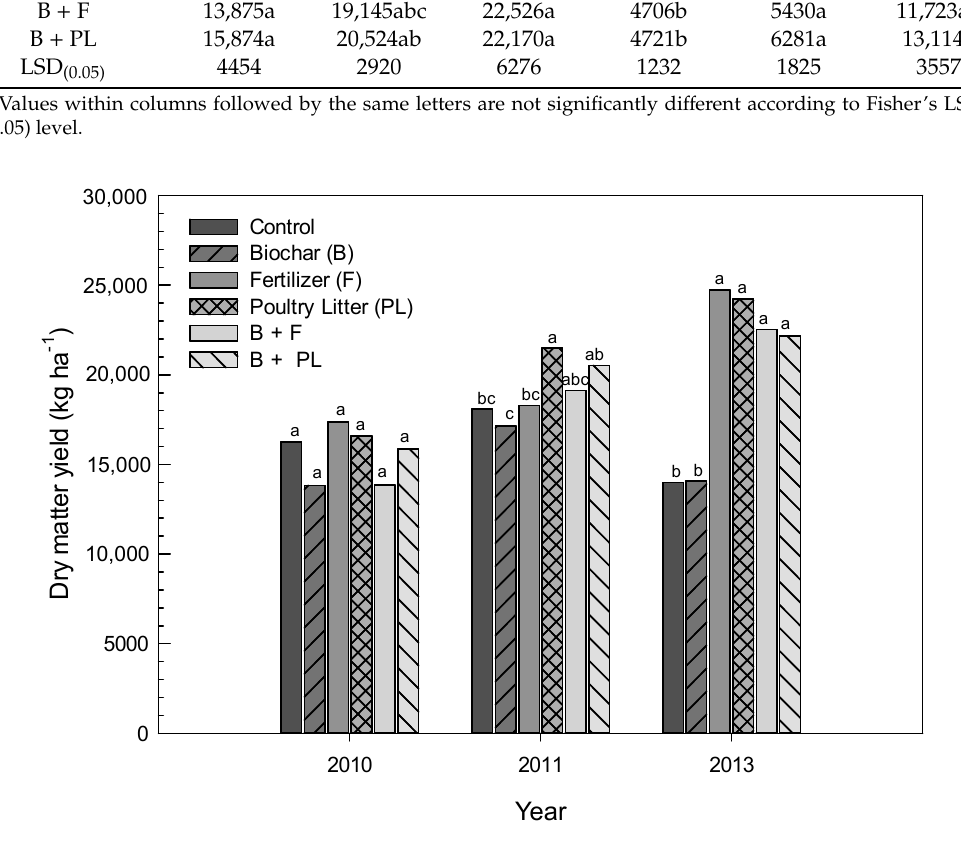
Figure 2. Effect of biochar, poultry litter, chemical fertilizer, and the combined treatments tested on corn dry matter yield in 2010, 2011, and 2013 growing seasons. Within each year, values followed by the same letters are not significantly different according to Fisher’s LSD (0.05) level.